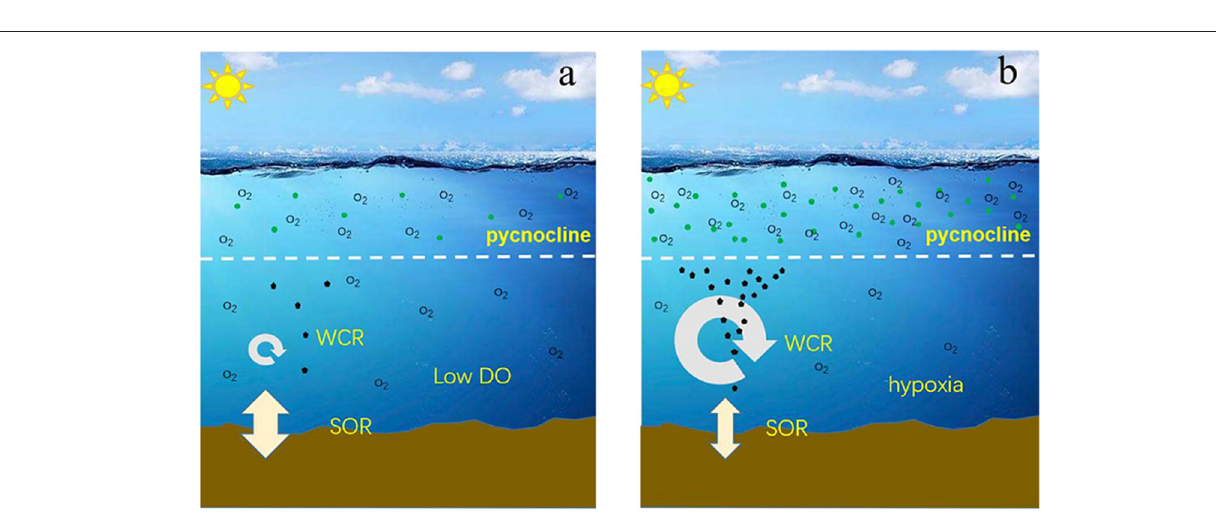
FIGURE 13 | Schematic of the dynamic WCR and SOR contributions to the total AOU at a fixed depth: (a) low DO ([O 2 ] > 2 mg/L) scenario when there is no excess organic matter exported into the near-bottom waters and SOR dominates the bottom AOU; (b) hypoxia scenario when there is excess organic matter exported into the near-bottom waters and WCR drives [O 2 ] to a hypoxic